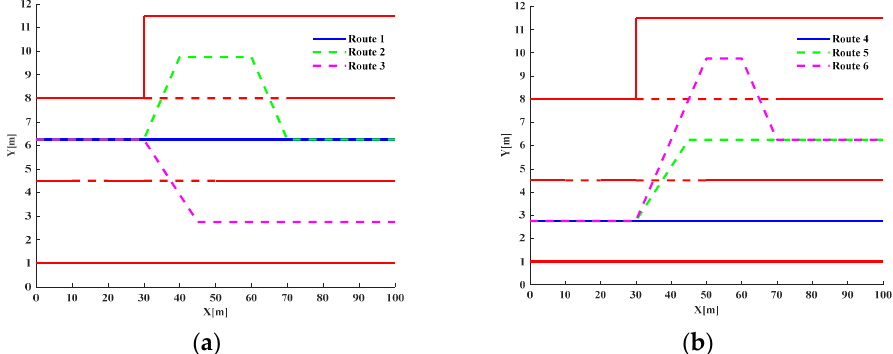
Figure 14. The directed graph of Figure 13.